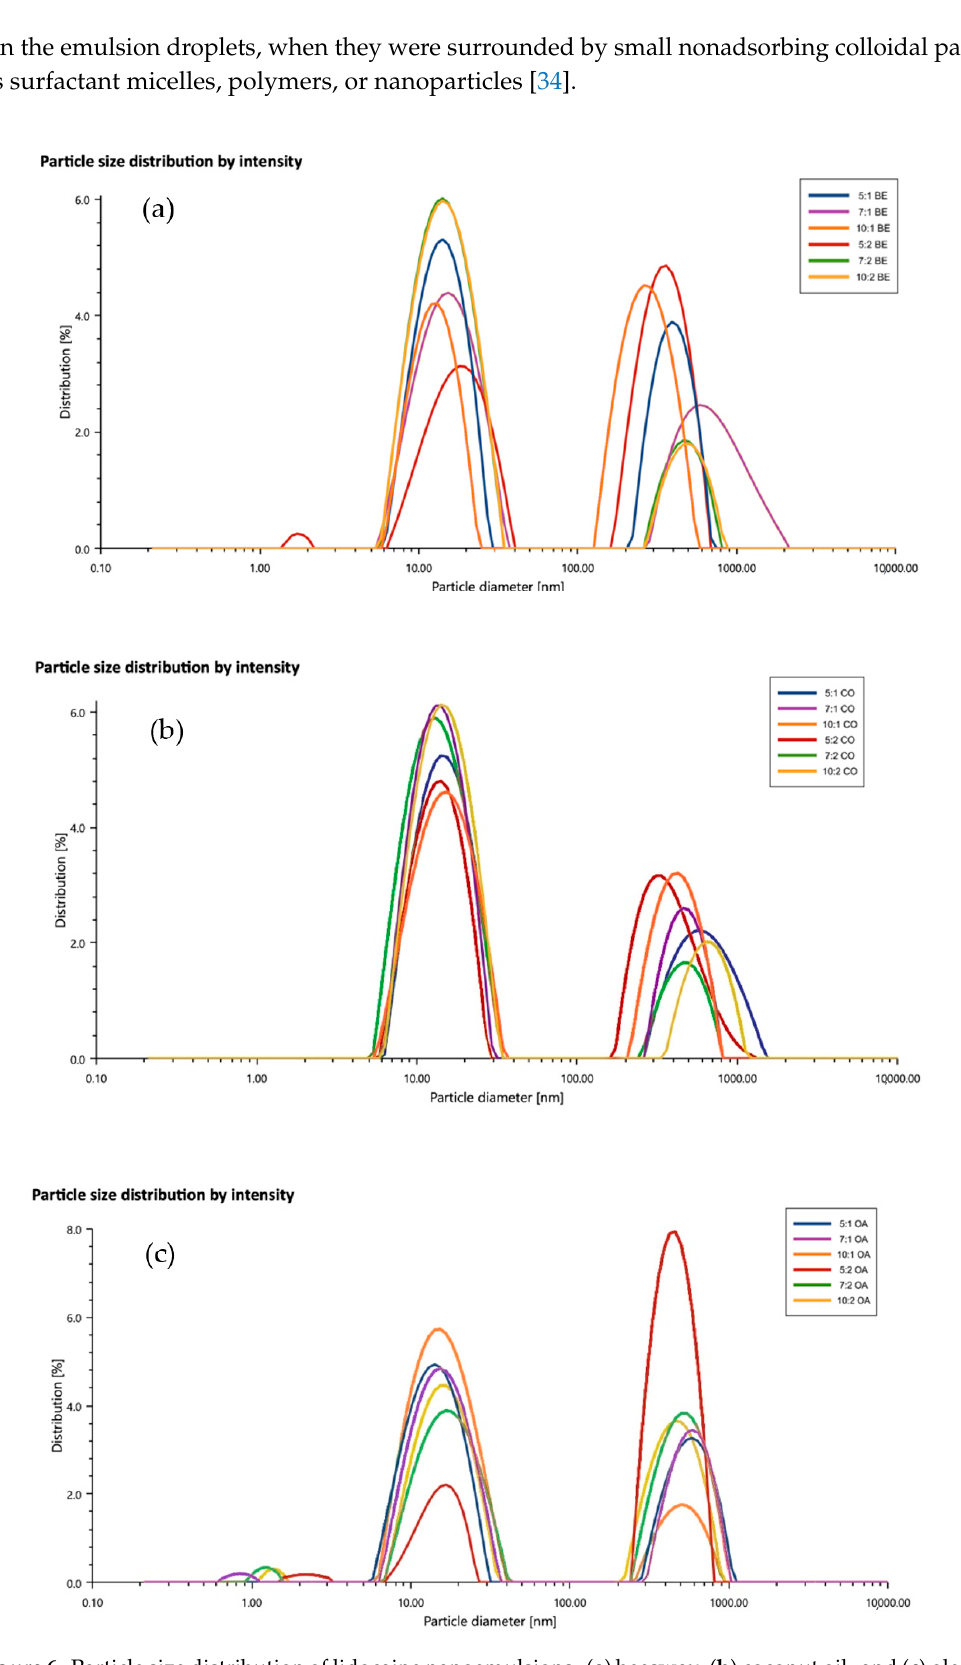
Figure 6. Particle size distribution of lidocaine nanoemulsions. ( a ) beeswax, ( b ) coconut oil. and ( c ) oleic acid formulations.